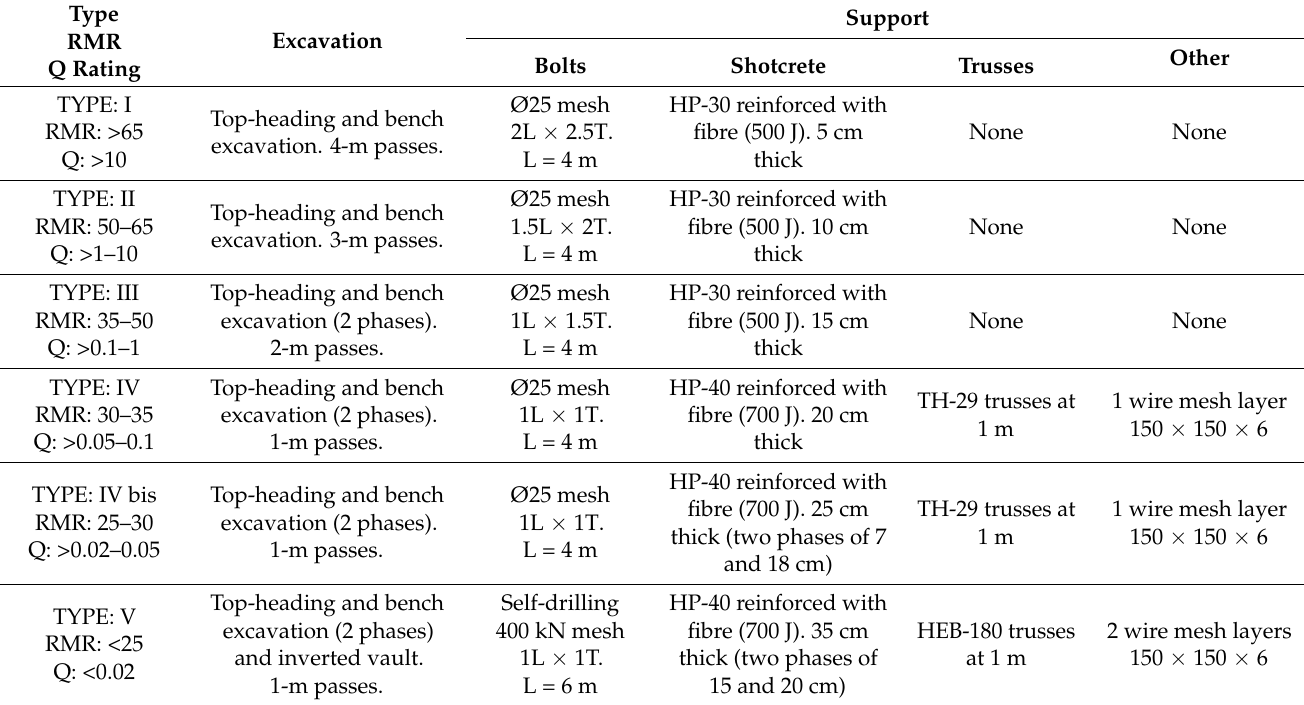
Table 3. Characteristics of the support types in the Arnotegi tunnel.